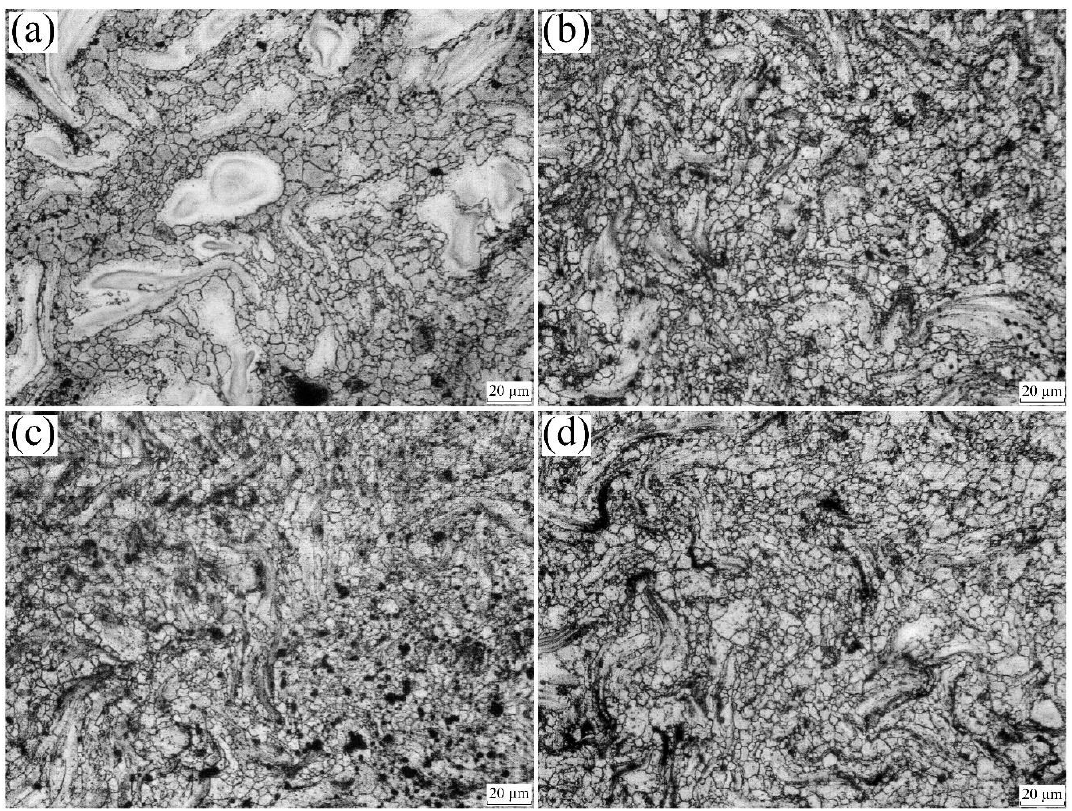
Figure 6. The surface microstructure before and after laser impact: ( a ) untreated; ( b ) 1.19 GW / cm 2 ; ( c ) 1.99 GW / cm 2 ; ( d ) 2.79 GW / cm 2